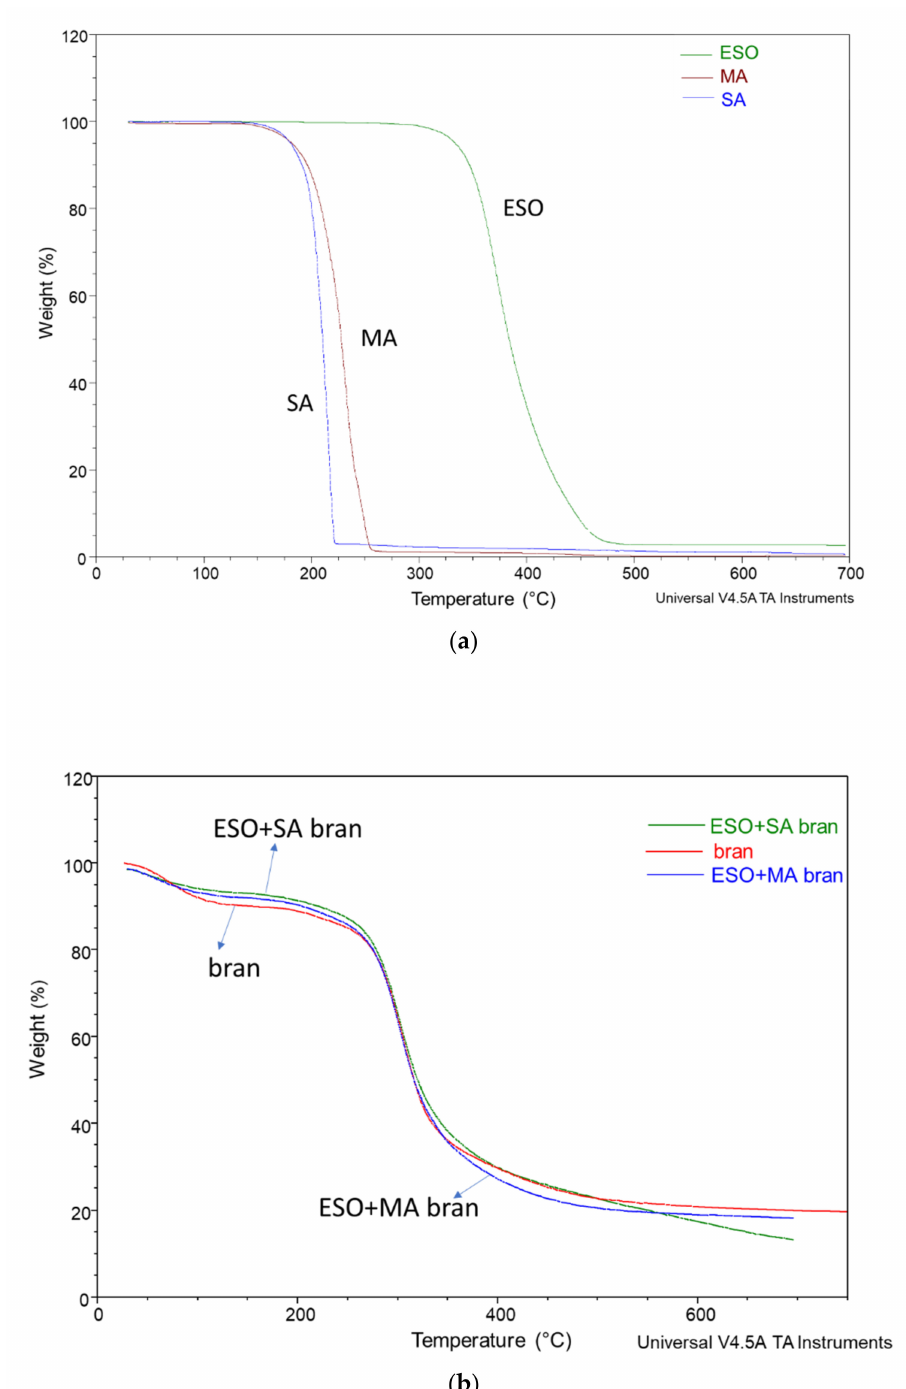
Figure 1. TGA curves related to ( a ) MA, SA and ESO; ( b ) bran, bran modified with ESO and MA and bran modified with ESO and